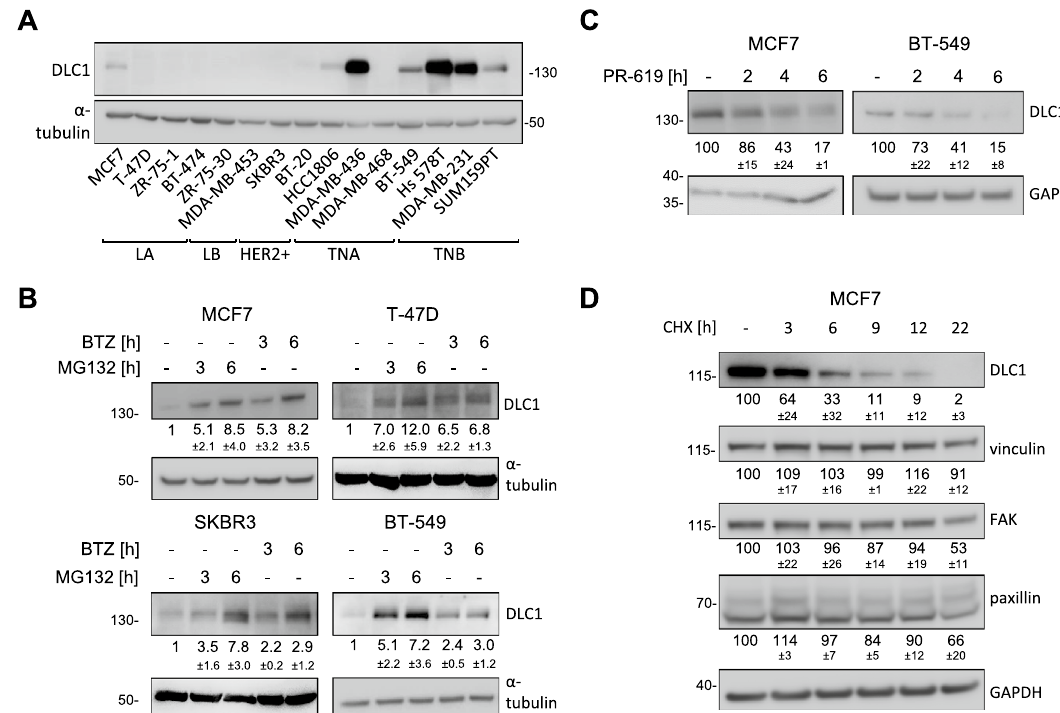
Figure 1. DLC1 undergoes rapid proteasomal degradation in breast cancer cells. ( A ) Lysates of the indicated breast cancer cell lines from different subgroups (luminal A (LA), luminal B (LB), HER2 positive (HER2 +), triple negative A (TNA), triple negative B (TNB)) were analyzed by immunoblotting with the indicated antibodies. ( B ) Cells were treated with MG-132 (10 µM) or bortezomib (BTZ, 100 ng/ml) as indicated and the lysates were analyzed by immunoblotting with the indicated antibodies. Control sample was treated with DMSO for 6 h. Western blots from three independent experiments were analyzed with ImageJ, the fold change in DLC1 expression was determined by normalizing the DLC1/α-tubulin ratio to that of control sample and is presented as mean ± s.d. Cropped blots shown from different cell lines are derived from separate blots. ( C ) Cells were treated with PR-619 (20 µM) as indicated and the lysates were analyzed by immunoblotting with the indicated antibodies. The control sample was treated with DMSO for 6 h. Western blots from three independent different cell lines are derived from separate blots. ( D ) MCF7 cells were treated with cycloheximide (CHX, 60 µg/ml) and lysates were analyzed by immunoblotting with the indicated antibodies. Western blots from